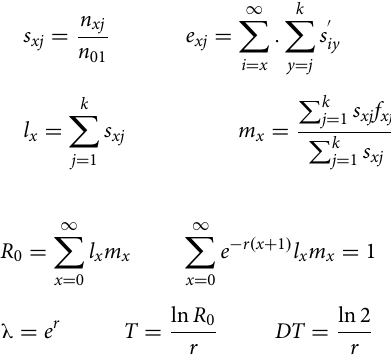
(Chi, 2021b). Means and standard errors of the population parameters were estimated via Bootstrapping with